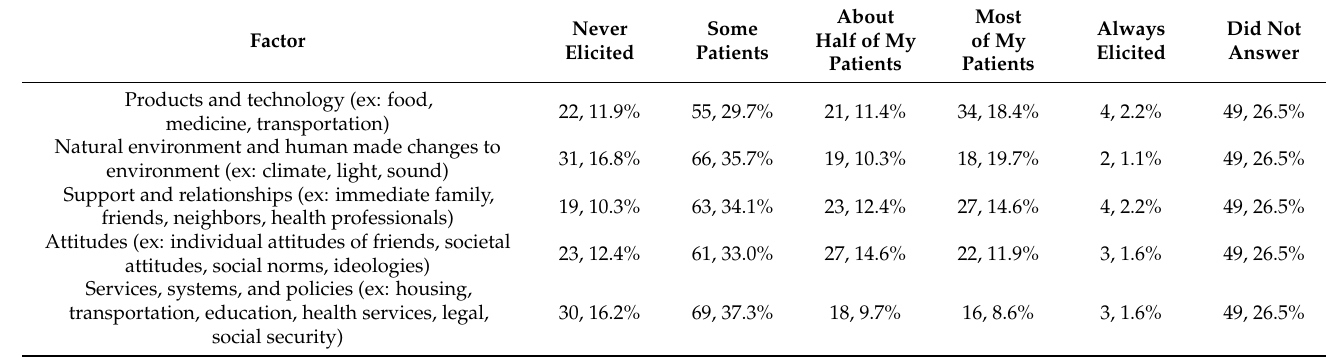
Table 8. Participant Report of Screening in Clinical Practice for Environmental Factors ( n , %).